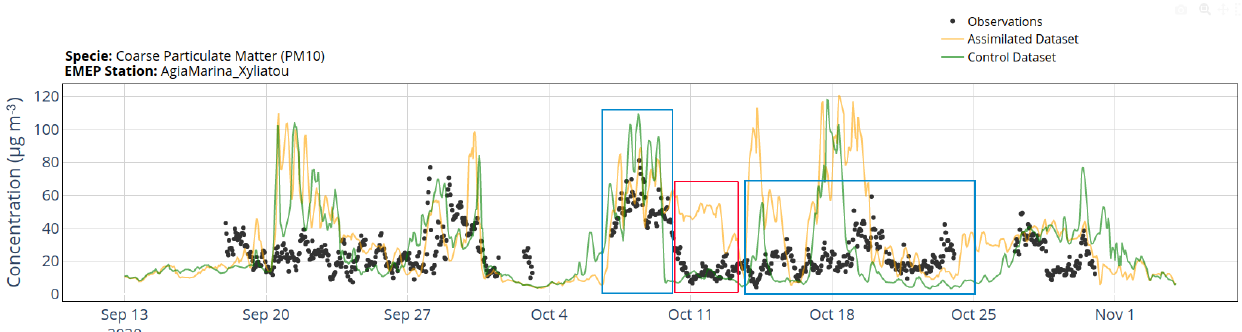
Figure 2. Time series of PM 10 concentrations recorded at Agia Marina, Cyprus, ground station for the months of autumn, where the green represents the control run, the yellow represents the assimilated run, and the black dots represent the observed values. Additionally, the blue highlighted boxes represent periods where the assimilated run outperforms the control run, while the red box represents the